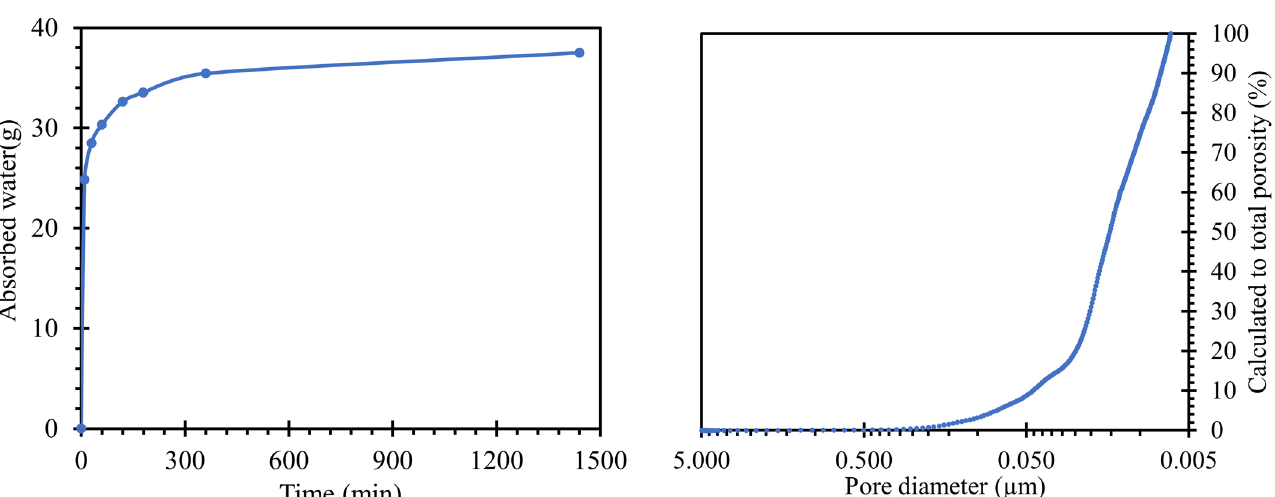
6 of 21 Figure 2. Hydration kinetics of used road cement using water to cement ratio of 0.3 recorded by means of isothermal calorimetry.